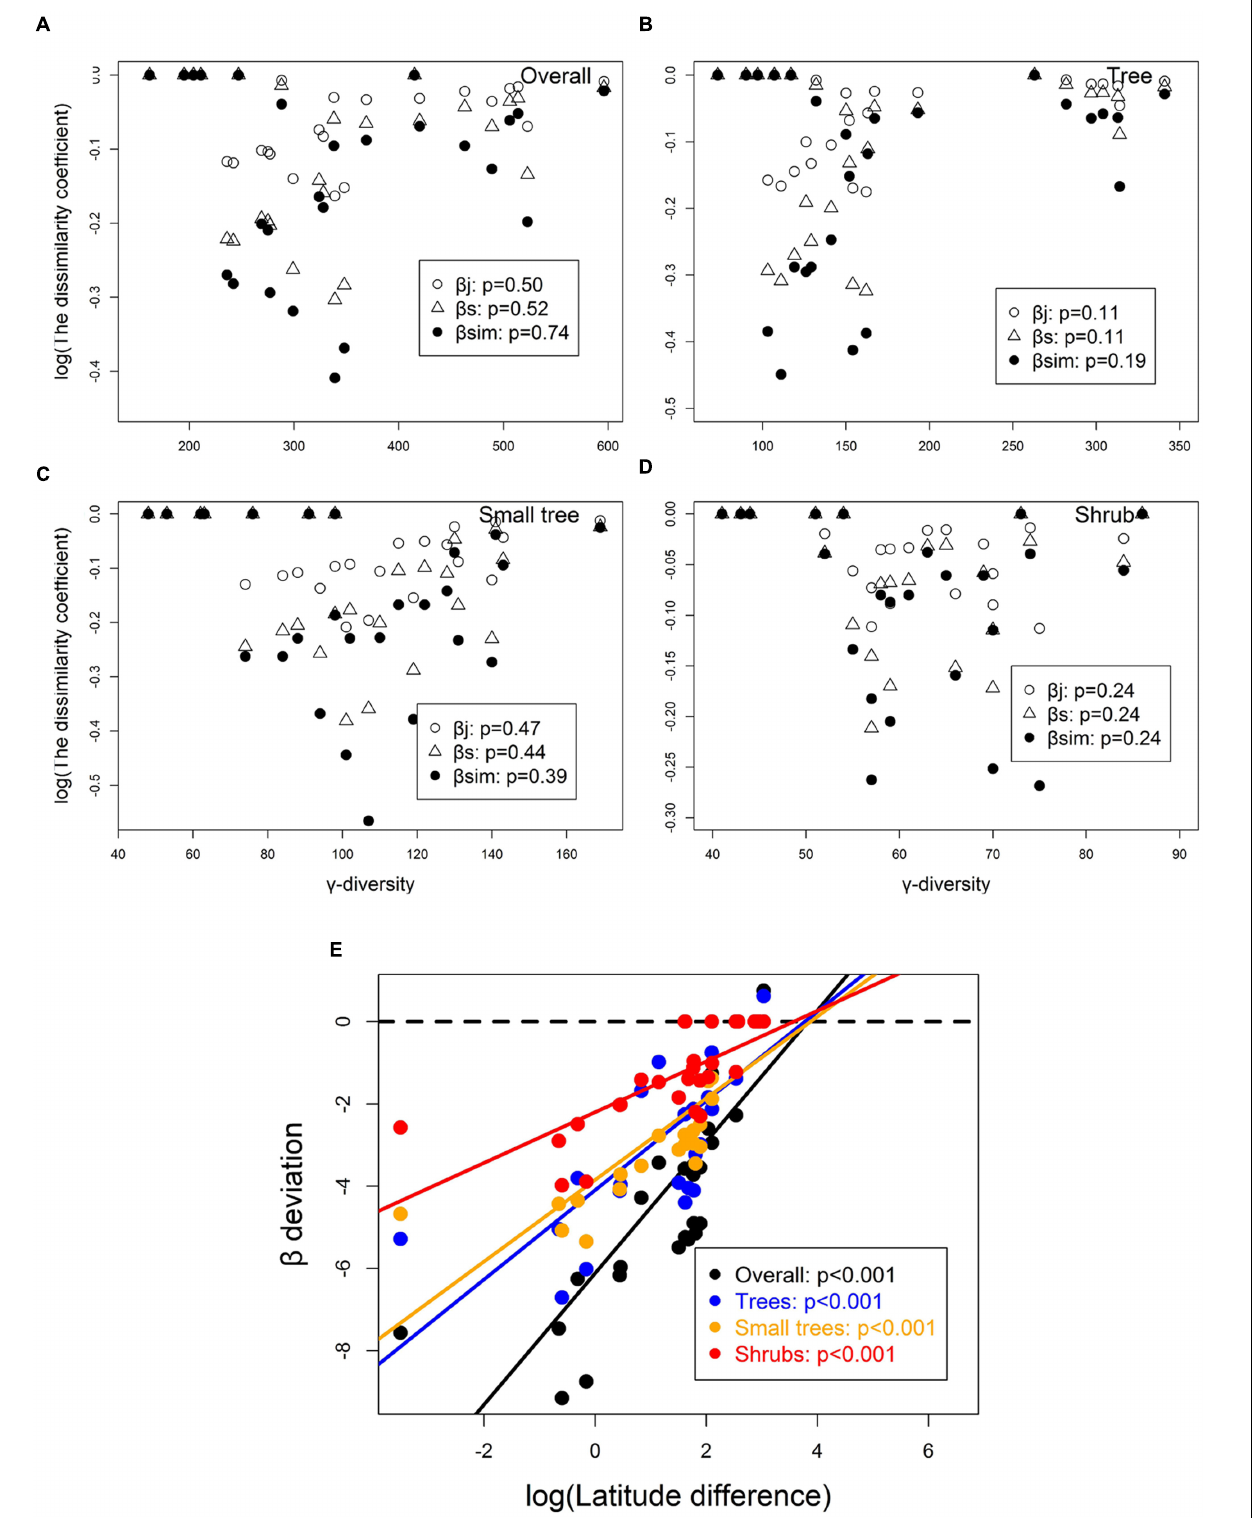
FIGURE 5 | Relationship between β - and γ -diversities for (A) overall, (B) tree, (C) small tree, and (D) shrub. Open dots represent β j , gray triangles represent β s , and solid dots represent β sim . A standard effect size of β -diversity deviations from a null model that corrects for γ dependence across with latitude difference (E) .